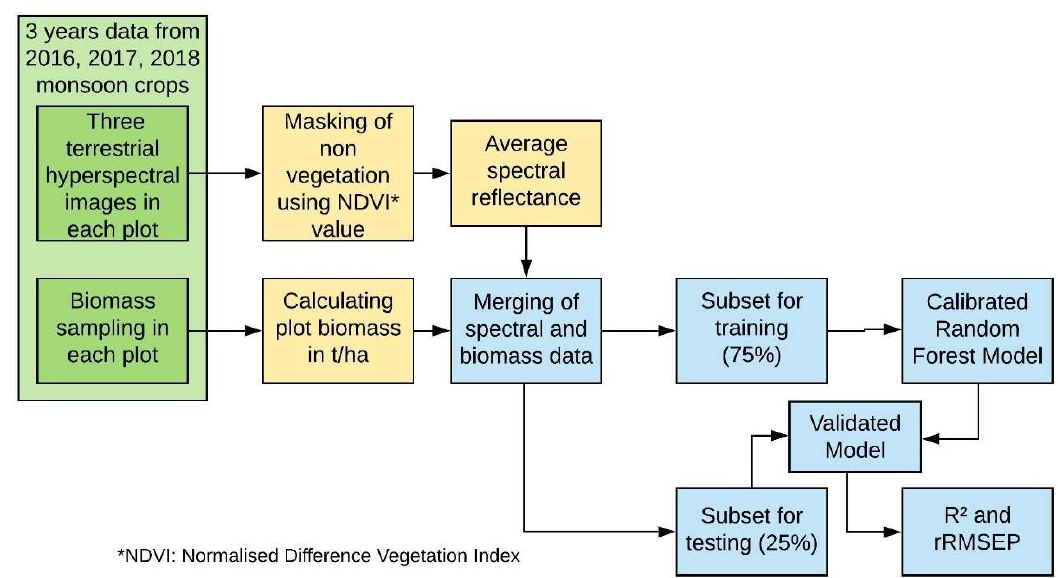
Figure 2. Workflow showing the data collection (green), data preparation (yellow) and data analysis (blue).